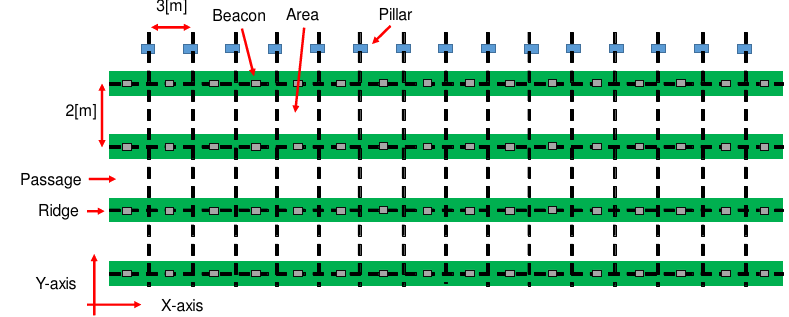
Figure 2. The greenhouse for cultivating tomatoes. There are four ridges and three passages extending across the experimental zone, which is in part of the